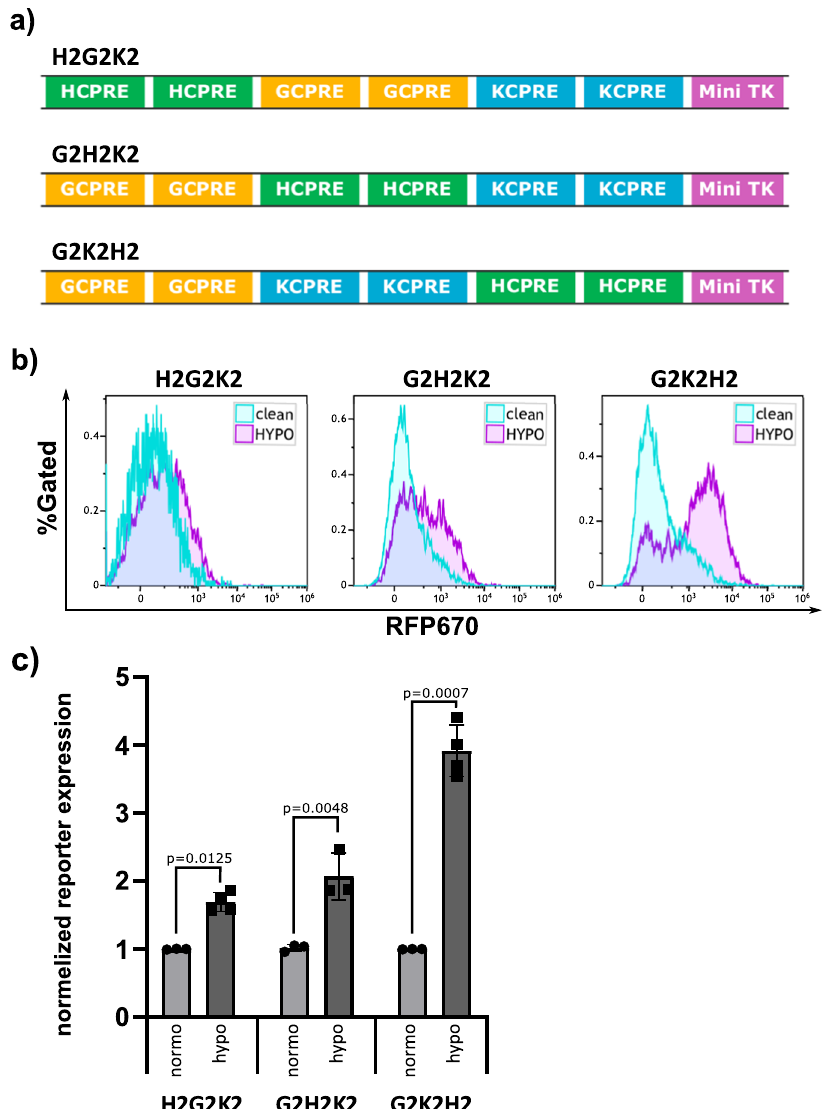
Fig. 3 The hypoxia PRE in CARTIV promotors is responsive and most potent when upstream of the minimal promotor. a Schematic drawing showing the different hypoxia element locations relative to the mini TK minimal promotor tested. b Representative plots of HEK293T cells infected using lenti viral vectors with RFP670 under the control of the indicated CARTIV promotor and ZsGreen controlled by the ef1 α core promotor. At 72 h following infection, the cells were placed under hypoxic conditions, incubated for 18 h, harvested and analyzed by fl ow cytometry. Data shown are ZsGreen-positive, single- discriminated, and DAPI-negative results. c Geometric mean of RFP670 in ZsGreen-positive cells normalized to unstimulated cells, showing the average of duplicates, error bars indicate standard deviation. A t test was performed to test for signi fi cance. Results are from one representative experiment of four